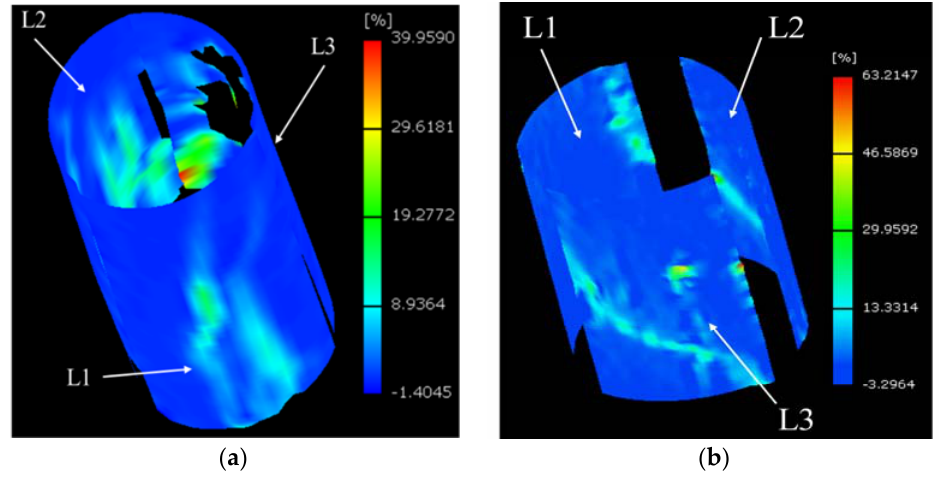
Figure 7. The spatial distribution of the major strains on specimen surface: ( a ) uniaxial compression; ( b ) triaxial compression.